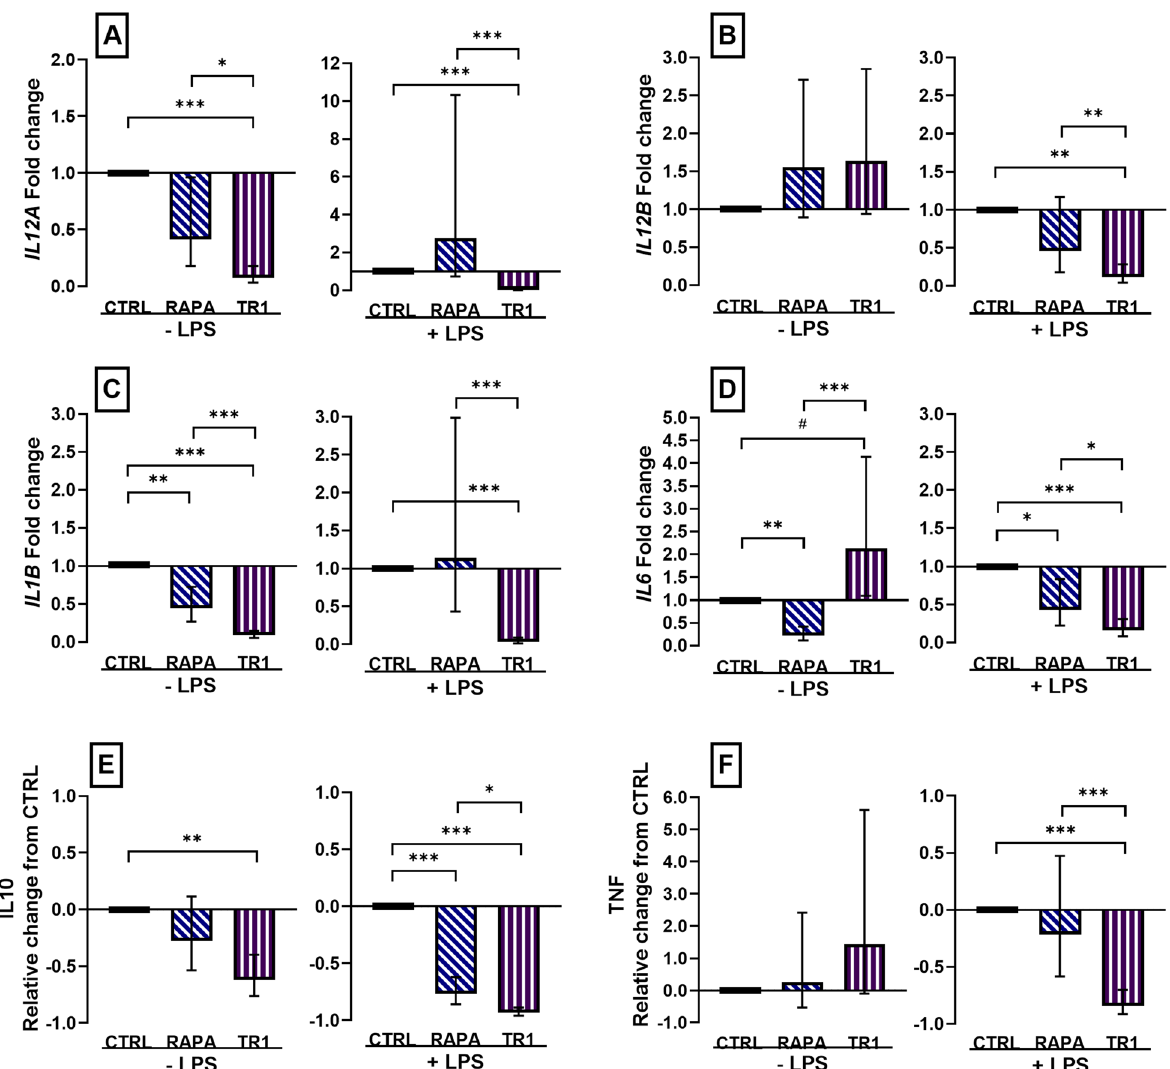
Figure 4. Changes in cytokine mRNA abundance and production in M2 macrophages polarized for 3 days with 20 ng/mL IL4 and 20 ng/mL CSF1 and concurrently treated with vehicle (CTRL), or inhibitors rapamycin (RAPA) or Torin-1 (TR1) at 100 nM. Cells were incubated with vehicle (− LPS) or stimulated with 100 ng/mL LPS (+ LPS) for 4 h to measure changes in mRNA abundance of IL12A , IL12B , IL1B, and IL6 ( A – D ), or for 16 h to measure production of IL10 and TNF protein ( E , F ). mRNA abundance was expressed as the fold change from CTRL in unstimulated and stimulated cells. Data from cell isolation of 12 cows were expressed relative to CTRL and presented as the relative change from CTRL in unstimulated and stimulated cells for cytokine production. Data are presented as the geometric mean and backtransformed 95% confidence interval. ANOVA tests between CTRL and inhibitors, and between inhibitors are presented with Bonferroni-adjustment for multiple comparisons: P ≤ 0.10 ( # ), P ≤ 0.05 (*), P ≤ 0.01 (**), P ≤ 0.0001 was 20-fold greater ( P < 0.0001) in co-cultures with mature moDC [3.0 (1.5–6.0) vs. 69 (36–131) ng/mL in naïve and mature moDC, respectively]. Concentration of IFNG was increased ( P ≤ 0.07) in co-cultures of naïve and mature moDC that were treated with Torin-1 (Fig. 6C), but no treatment differences were found in intracellular IFNG measurements of CD4 + cells (Fig. 6D, E). As described above, the sample size of 12 individual cows for this study was based on an expected difference of 25 ng/mL and a SD of 20 ng/mL IFNG between treatments. Concentration of IFNG in mature co-cultures averaged (± SD) 89.0 ± 46.8, 134 ± 49, and 147 ± 40 ng/mL for CTRL, RAPA, and Torin-1 respectively, showing that both magnitude of difference between the mTOR inhibitor treatments and CTRL, as well as SD were about twice as high as described above. Regarding the concentration of other cytokines of interest in co-culture, IL10 was decreased ( P ≤ 0.04) in supernatants of Torin-1-treated naïve and mature moDC, whereas TNF concentrations increased ( P ≤ 0.03) in co-cultures of both naïve and mature moDC that were treated with RAPA or Torin-1 (Fig. 6A, B).